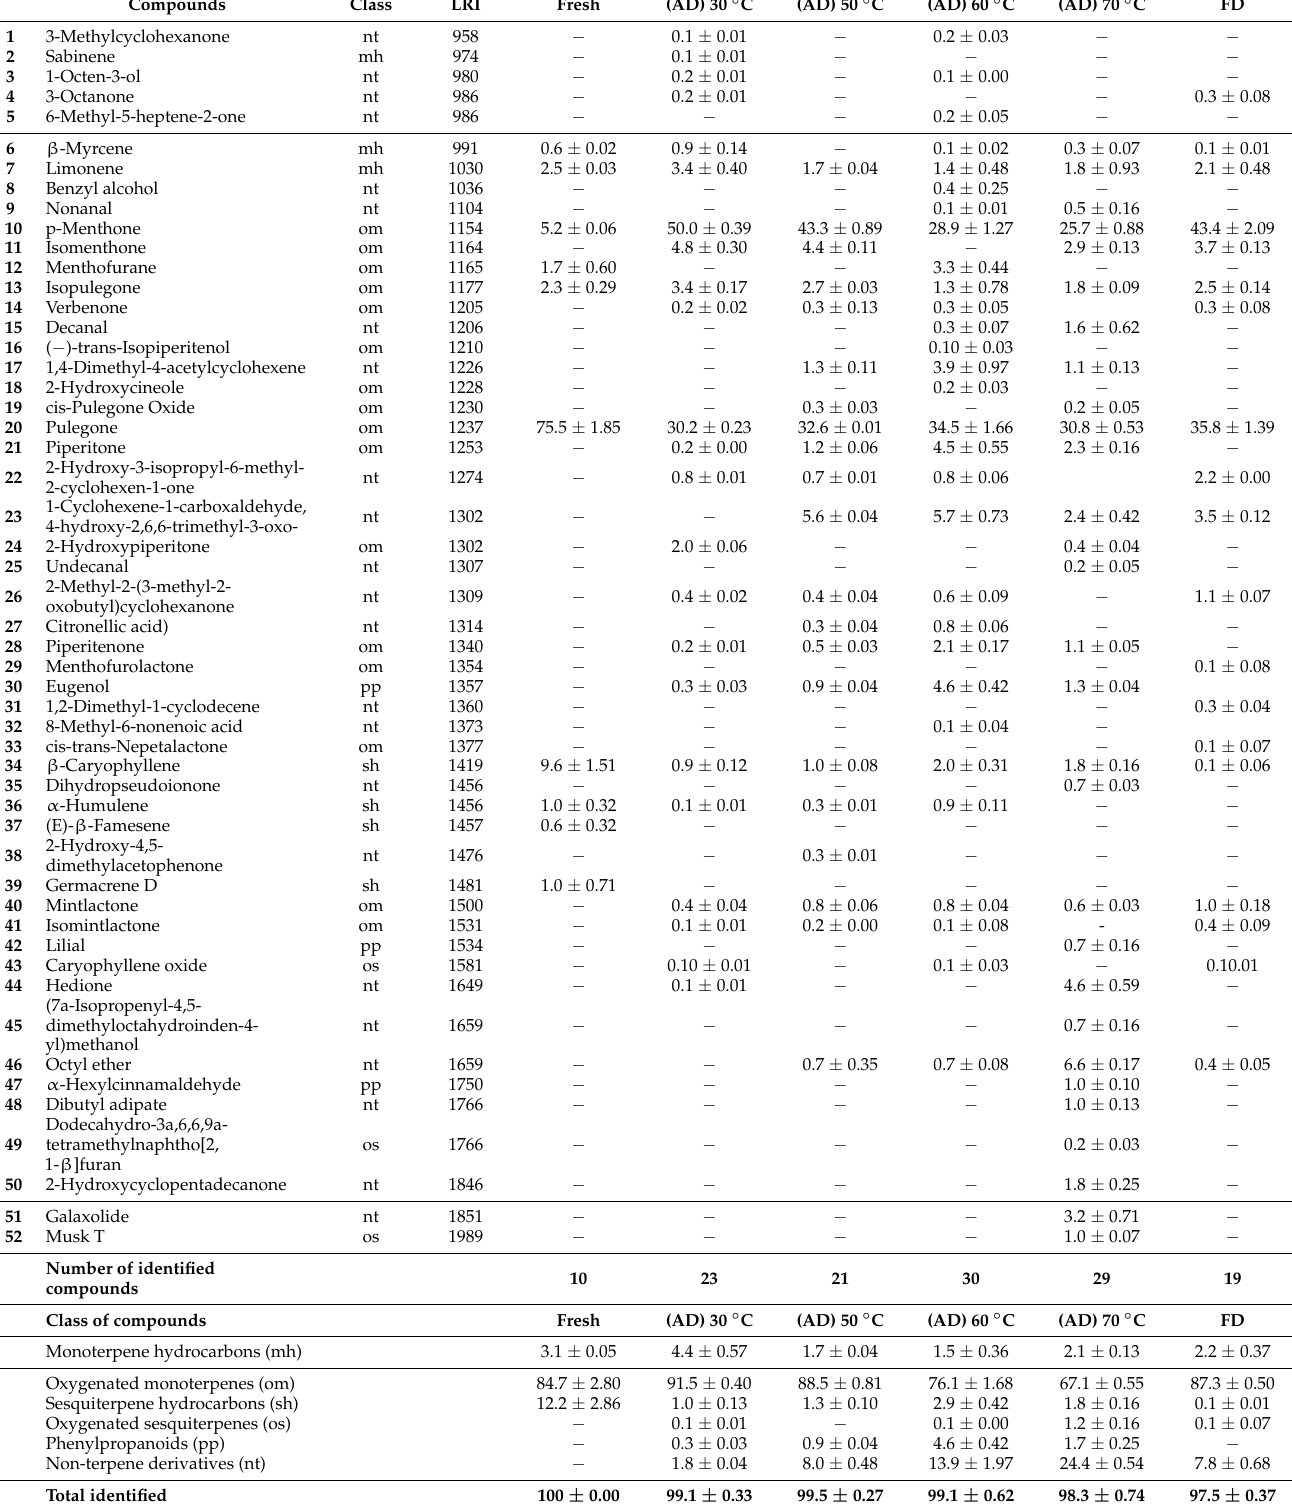
Table 2. Chemical composition of the volatile organic compounds (VOCs) from A. aurantiaca ‘Apricot Sprite’ flowers. Headspace–Solid Phase Micro-Extraction (HS-SPME) was performed on Gas Chromatography–Mass Spectrometry (GC–MS) with DB-5 capillary column. Data represent mean values of relative percentage ( n = 3, ±